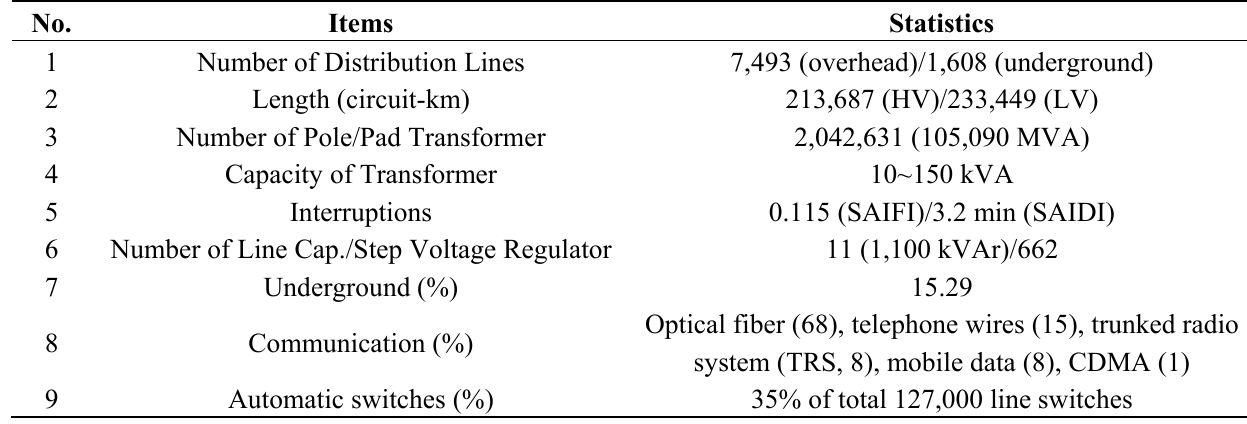
Table 1. Current status of the Korean distribution network (August